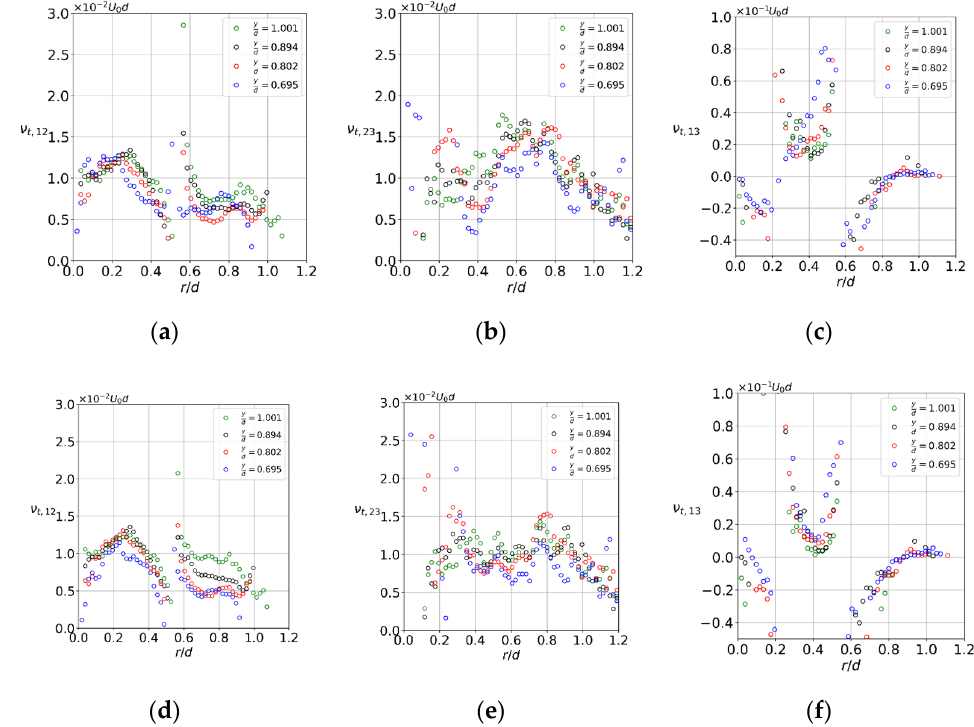
Figure 13. Turbulent viscosity coefficients for ( a – c ) total and ( d – f ) stochastic turbulent fluctuations for high-swirl jet.